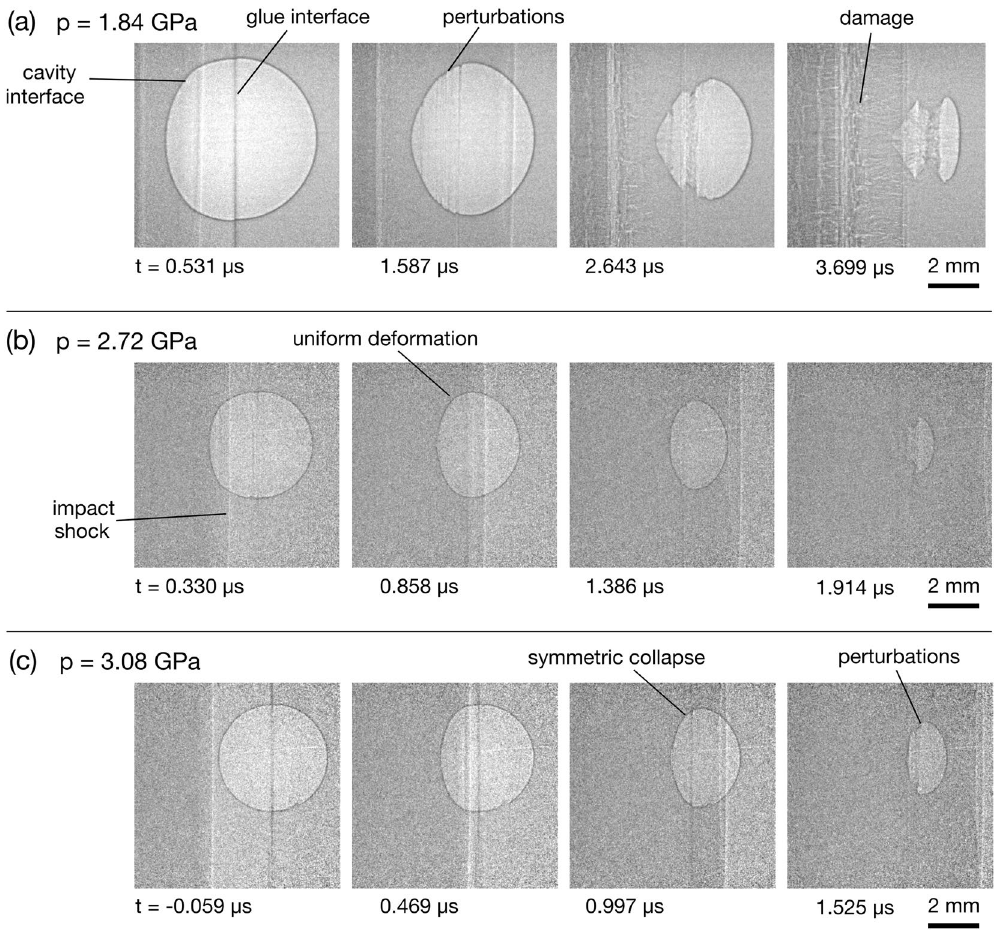
Figure 4. Radiograph sequences showing shock-cavity interactions in the transition regime. ( a ) A 6 mm cavity and 1.84 GPa shock. ( b ) A 4 mm cavity and 2.72 GPa shock. ( c ) A 4 mm cavity and 3.08 GPa